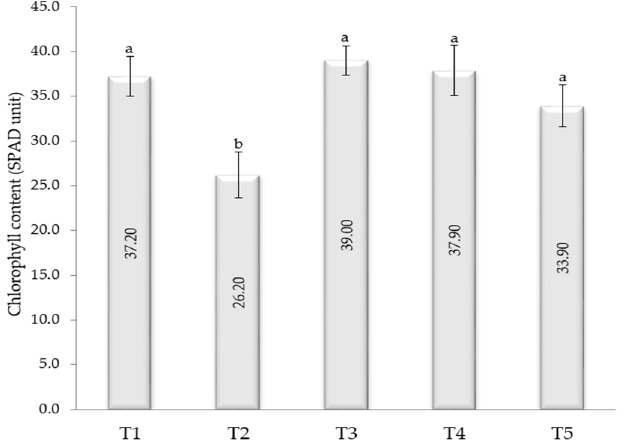
Figure 6. Chlorophyll content (SPAD unit) of tomato plants under greenhouse conditions as affected by T. asperelloides Ta41 with or without R. solani infection. T1: tomato plant control inoculated with media-free microorganisms; T2: tomato plants inoculated with R. solani only; T3: tomato plants inoculated with T. asperelloides ; T4: tomato plants inoculated with T. asperelloides 48 h before inoculation with R. solani (protective application); T5: tomato plants inoculated with T. asperelloides 48 h after inoculation with R. solani (curative application) . Data with the same letters are not significantly different at p ≤